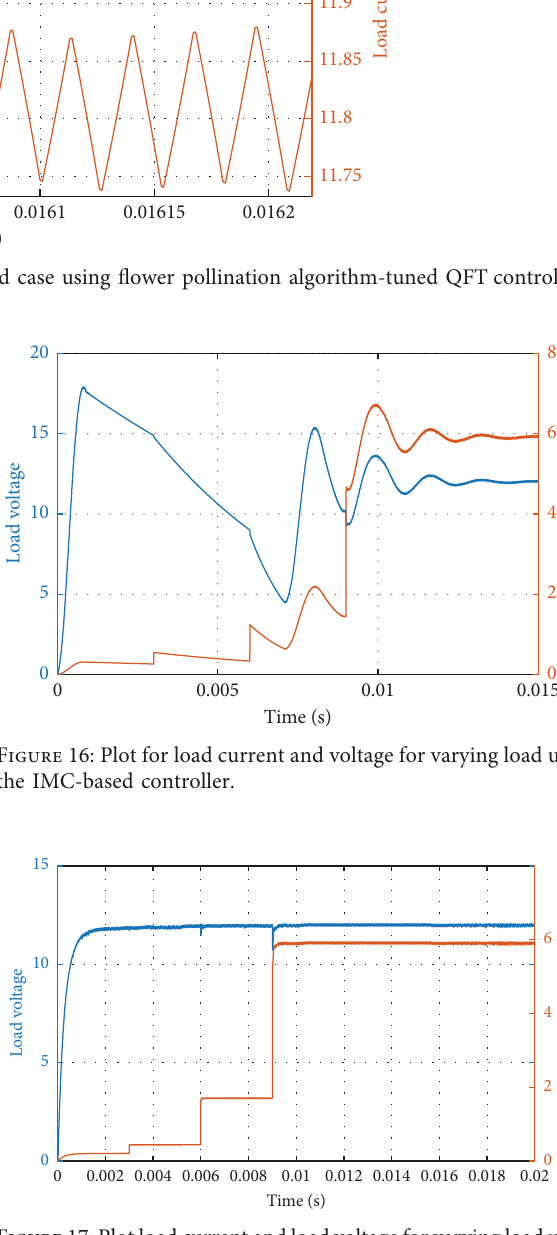
Figure 17: Plot load current and load voltage for varying load using the QFT controller proposed by L